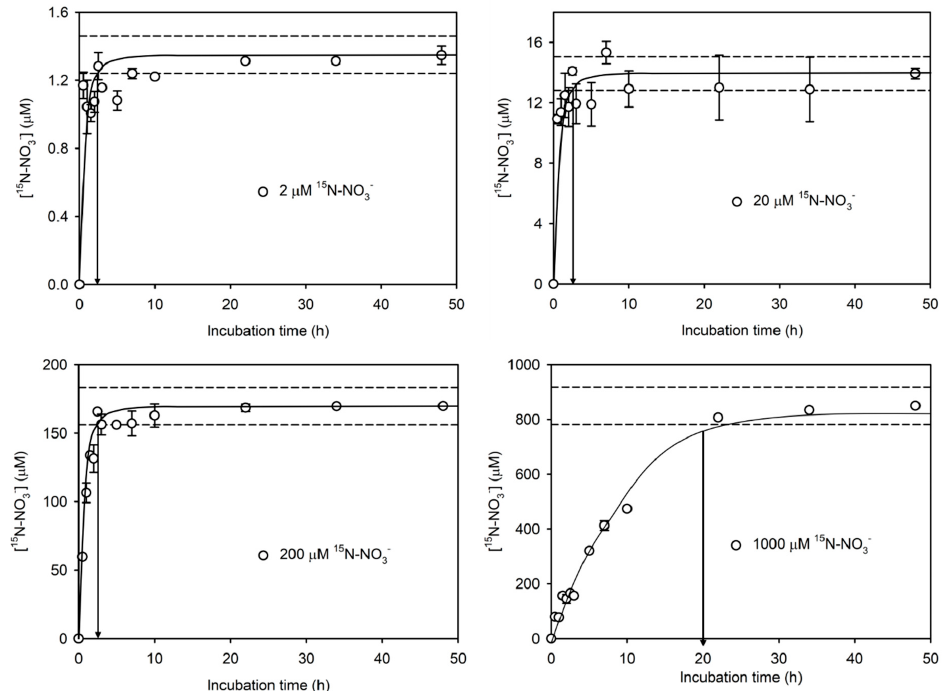
Figure 3. Results of the time series experiment targeting the proper incubation time to recover >95% of the added 15 N-NO 3 − converted into 30 N 2 . The plateau of 30 N 2 production ±5%, shown graphically by the dotted lines, was defined experimentally from the slurries sacrificed after 48 h. Arrows indicate a minimum incubation time that in three out of four levels of nitrate is <5 h, while for the highest level is nearly 20 h. Continuous lines show graphically the temporal evolution of 15 N-NO 3 − recovery (= 30 N 2 production). Each slurry was run in triplicate; averages and standard errors are reported.